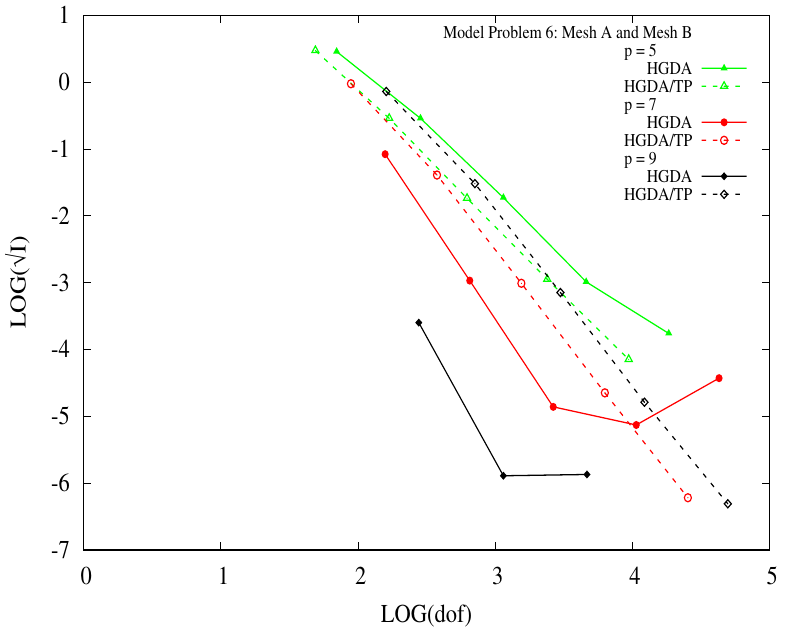
Figure 32. Residual function I versus dof, C 22 solutions: Model Problem 6 (Burgers Equation; Mesh B, HGDA/DG; Mesh A,